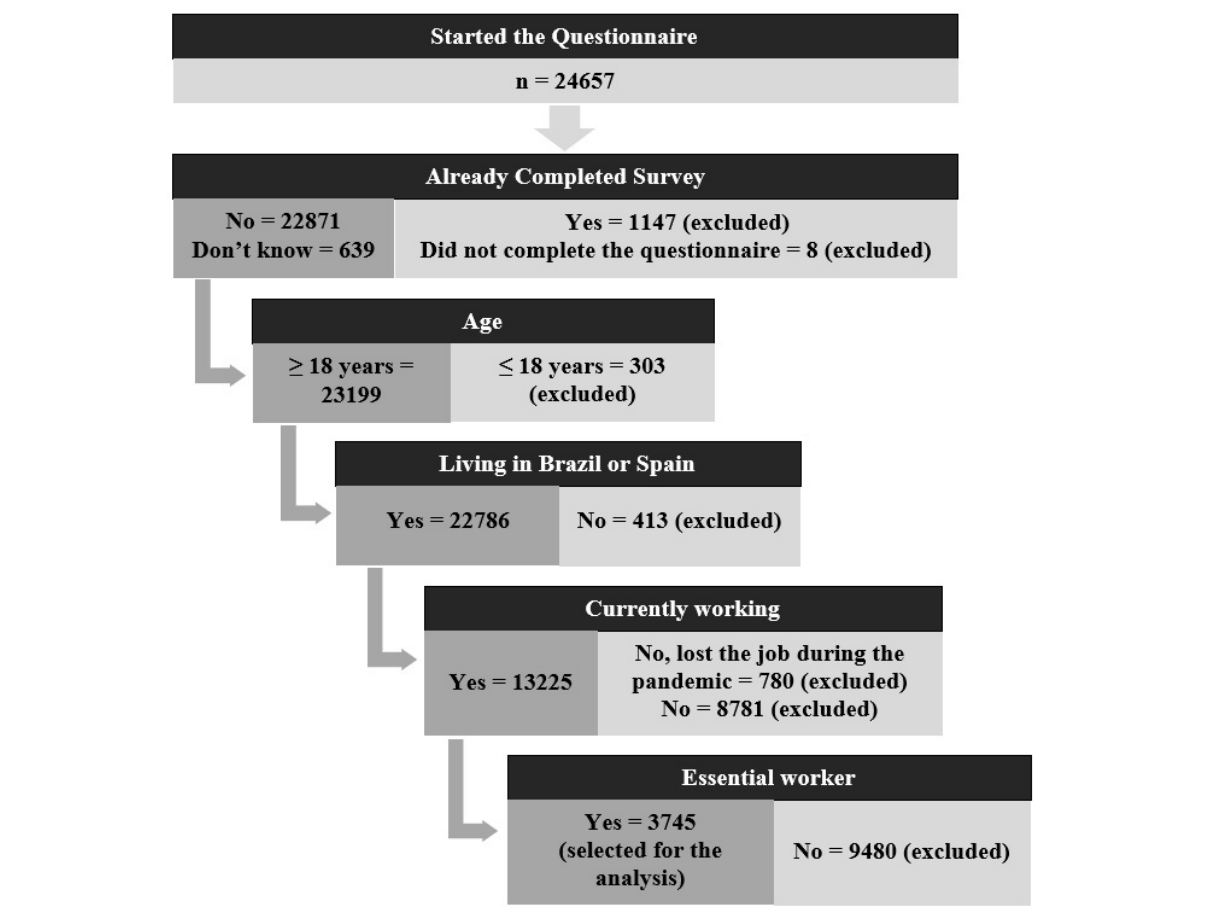
Figure 2. Inclusion